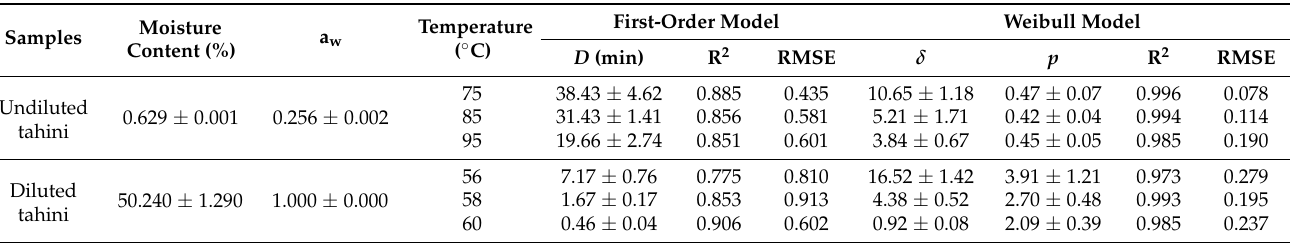
Figure 2. Thermal inactivation kinetics of S. Montevideo CICC21588 in undiluted (a w = 0.256) ( a ) and diluted tahini (a w = 1.000) ( b ) at different temperatures. Table 1. Fitted D -values of the first-order kinetic model and δ - and p -values of the Weibull model for thermal inactivation of S . Montevideo CICC21588 inoculated into undiluted or diluted tahini at different temperatures with heating rate of 5 ◦ C/min using TDT